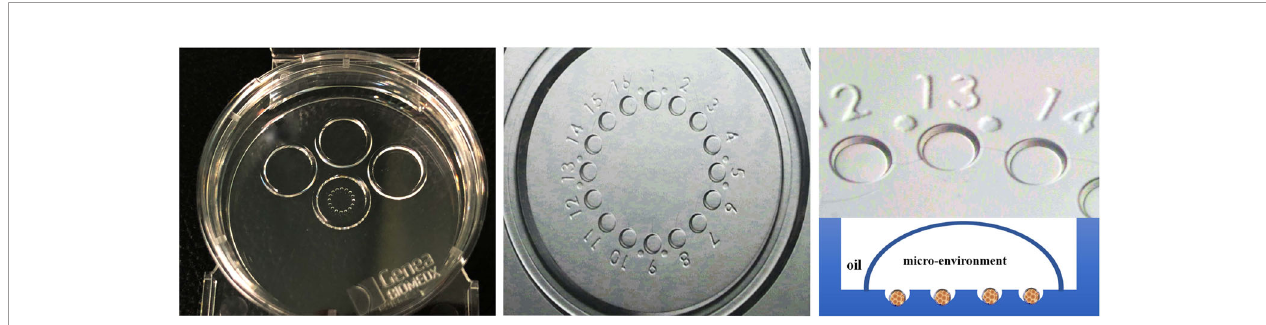
FIGURE 1 | The WOW-based 16-microwell GERI dish. The WOW-based dish uses narrow, deep microwells to designate the place of each embryo within a close distance from each other, to facilitate autocrine signaling and enable paracrine communication between sibling